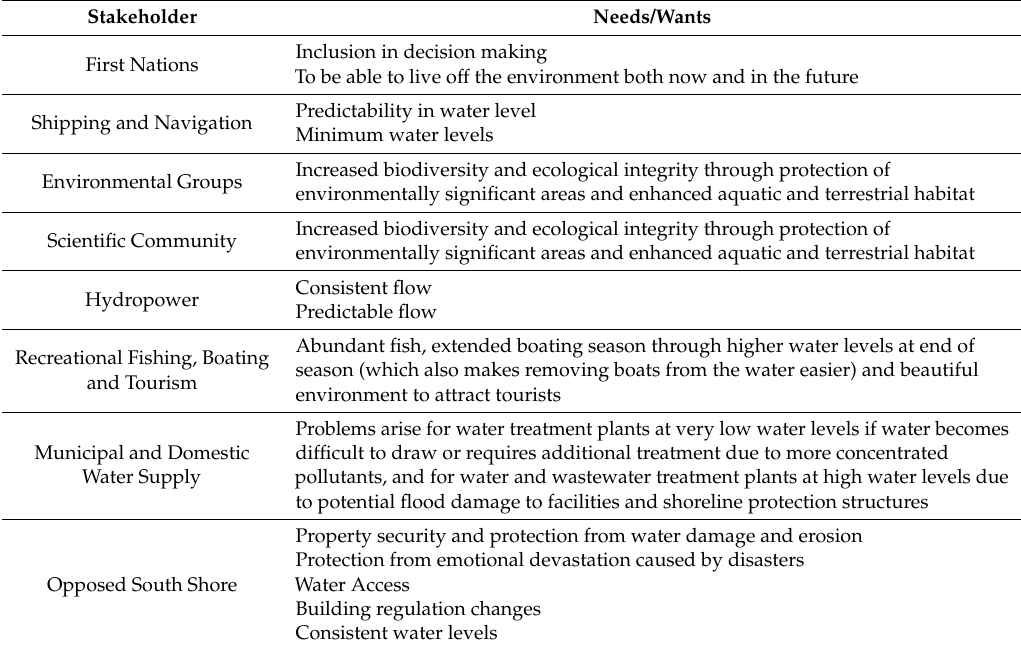
Table 4. Needs or wants of key